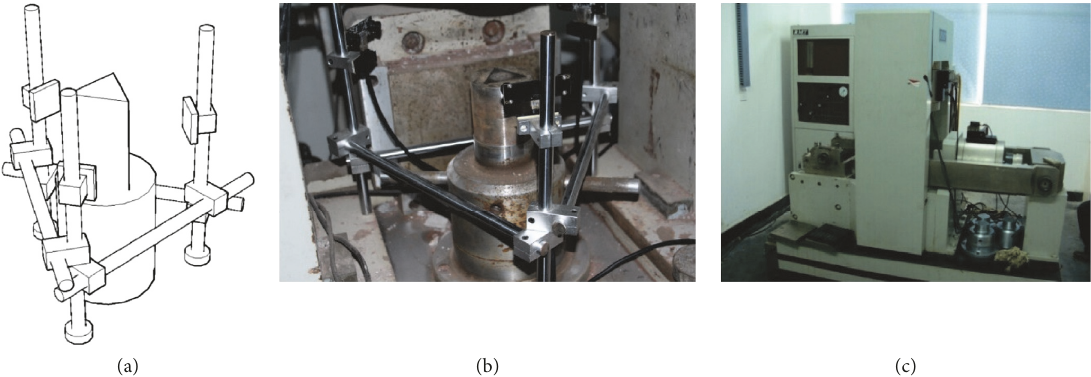
Figure 15: The uniaxial compression equipment. (a) The principle of the 3D crack observing instrument. (b) The 3D crack observing and recording instrument. (c) RMT-150B testing machine.